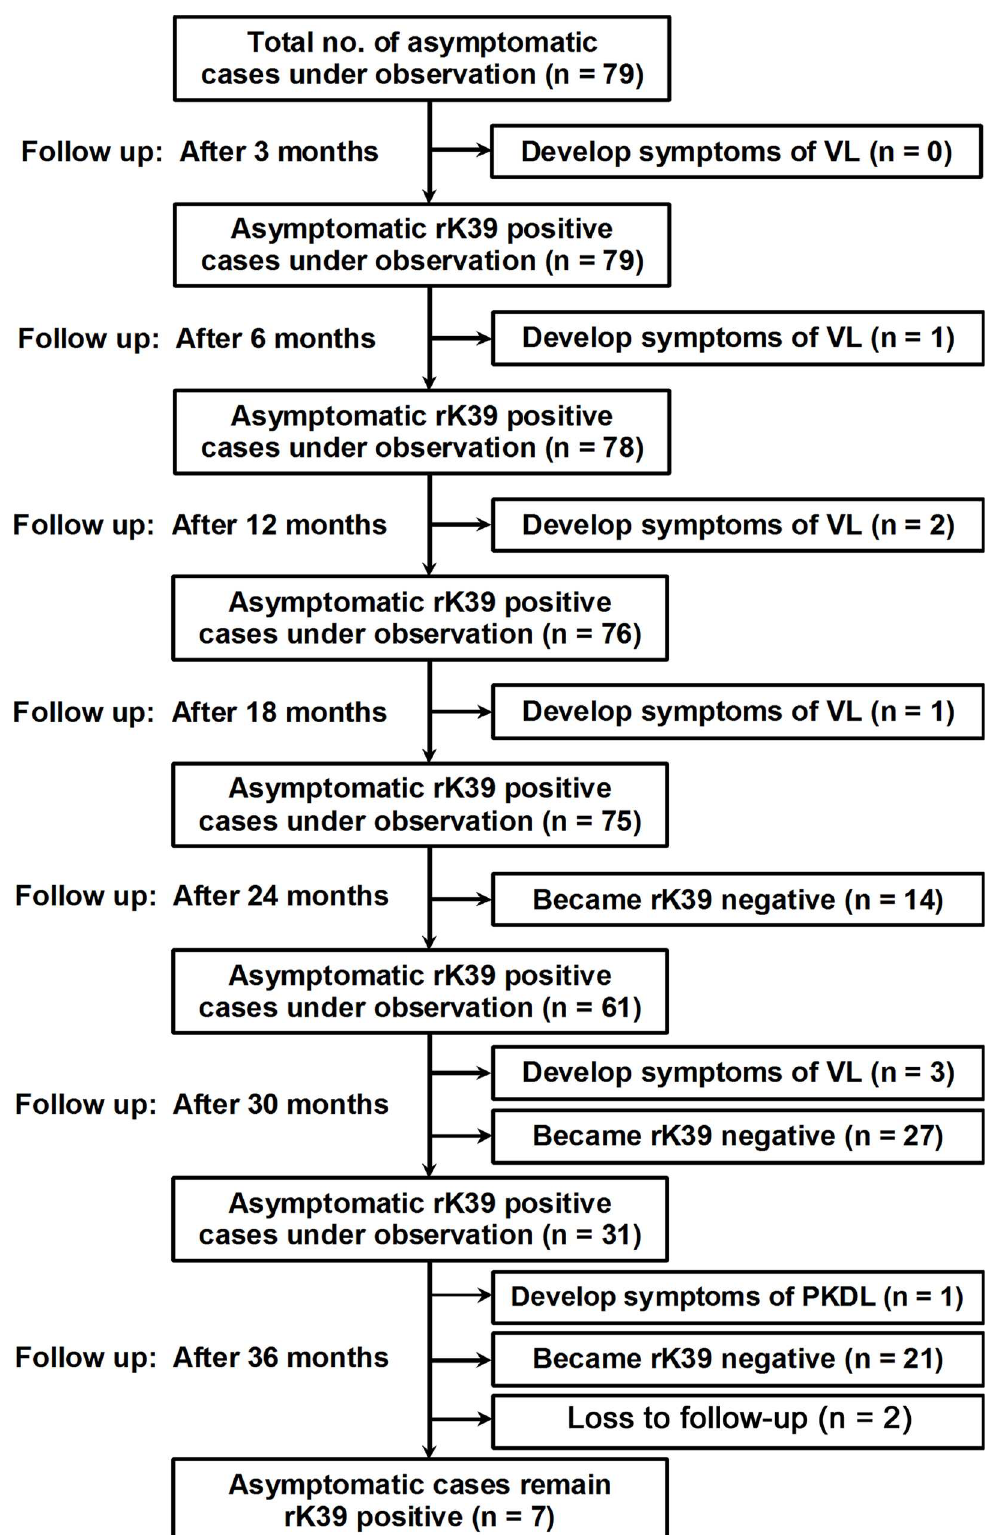
Fig 2. Flow chart showing the follow-up of asymptomaticVL casesand their sero-conversion pattern.